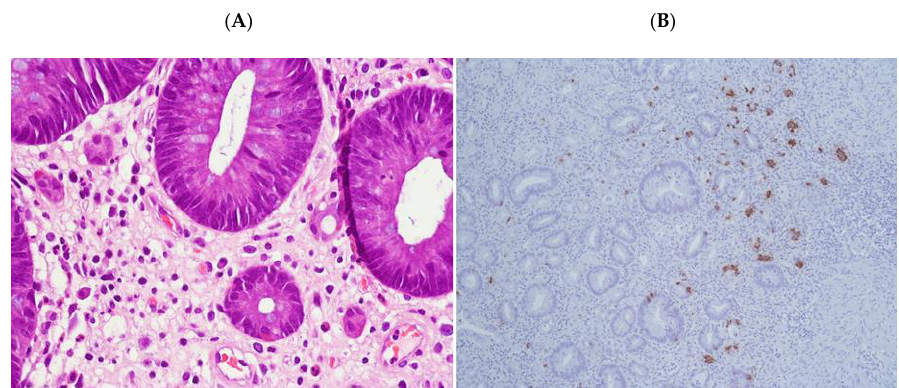
Figure 5. ( A ) Endocrine cells in radiation-damaged non-neoplastic mucosa in PSRT sample (Hematoxylin and Eosin (HE) 200 times magnified); ( B ) chromogranin immunostaining highlighting endocrine cells in radiation-damaged non-neoplastic mucosa in PSRT sample (100 times magnified).